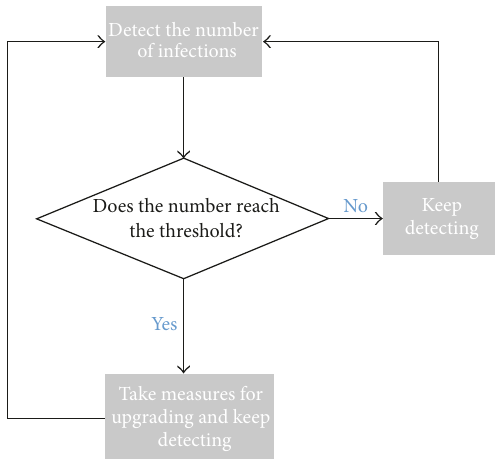
Figure 1: Flow diagram of